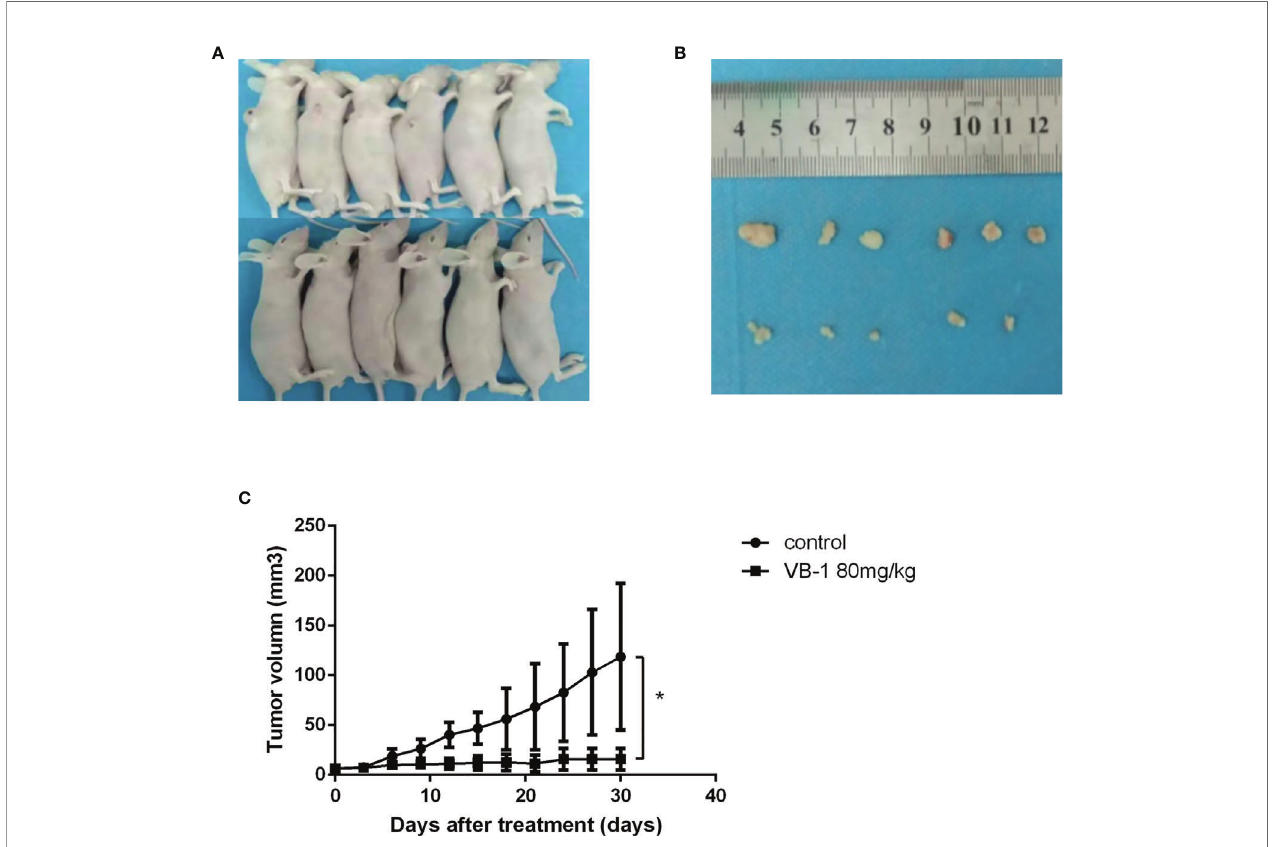
FIGURE 4 | VB1 can inhibit tumor growth in a xenograft tumor model. (A) Tumor-bearing nude mouse model after treatment. (B) VB1-treated mice demonstrated a dramatically reduced tumor volume as compared with vehicle-treated mice. (C) Tumor growth curves indicate a poor tumor growth in VB1-treated mice compared with vehicle-treated mice. The results represent the mean ± SD per group. *P < 0.05 compared with the control